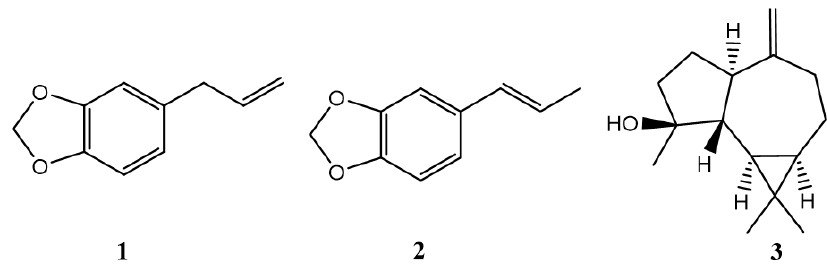
Figure 1. Structures of the main compounds present in the EO of L. sempervirens